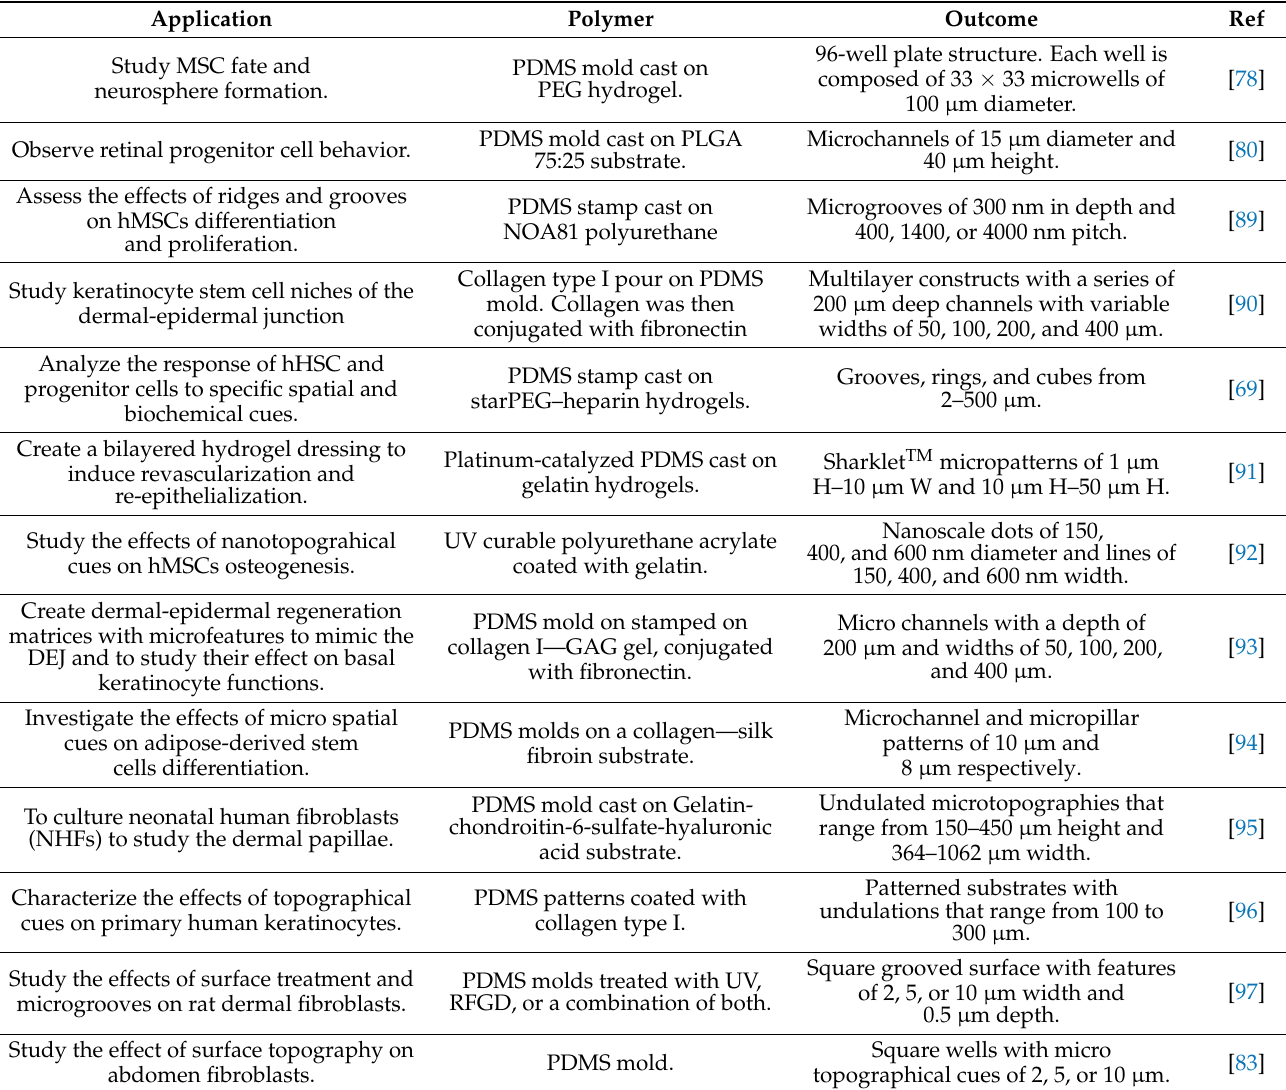
Table 2. Summary of soft-lithographic constructs used to recreate the micro and nano spatial cues of the stem cell niche.